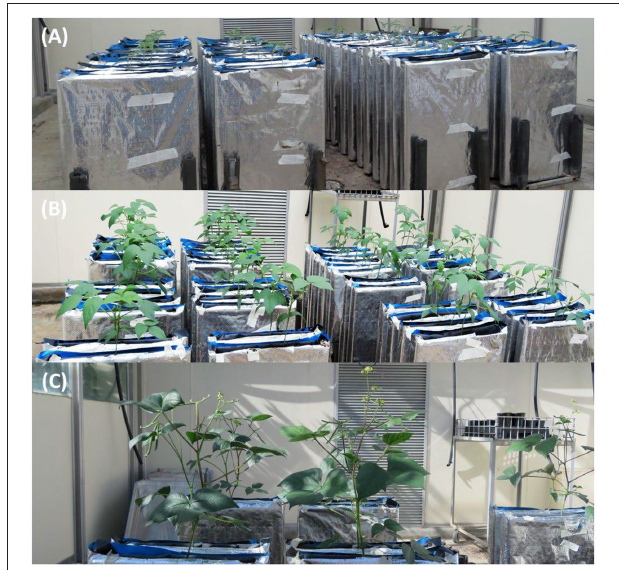
FIGURE 1 | Mungbean plants growing in root chambers in a temperature-controlled glasshouse with four replications. (A) Before harvest 1, (B) harvest 2, and (C) harvest